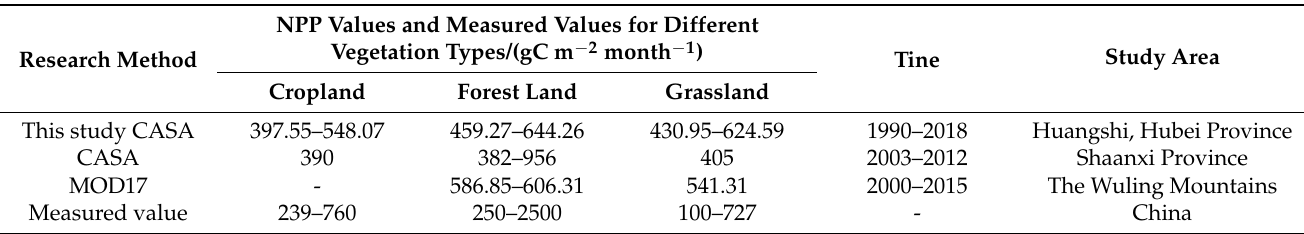
Table 4. Comparison of NPP estimated value and actual measured